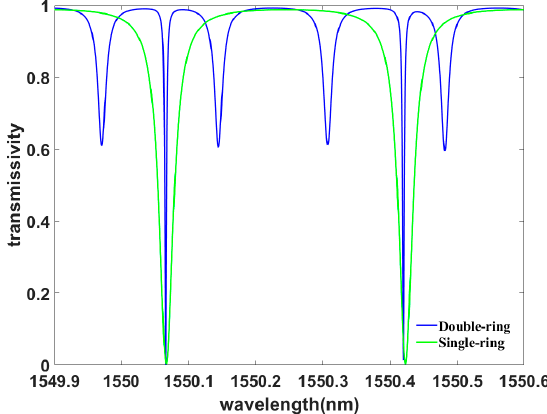
Figure 10. Transmission characteristic curves of the single ring (green line) and the double ring (blue line) resonators at ρ = 3dB/m, t 2 = 0.9, t 3 = 0.995, t 1 = 0.779.